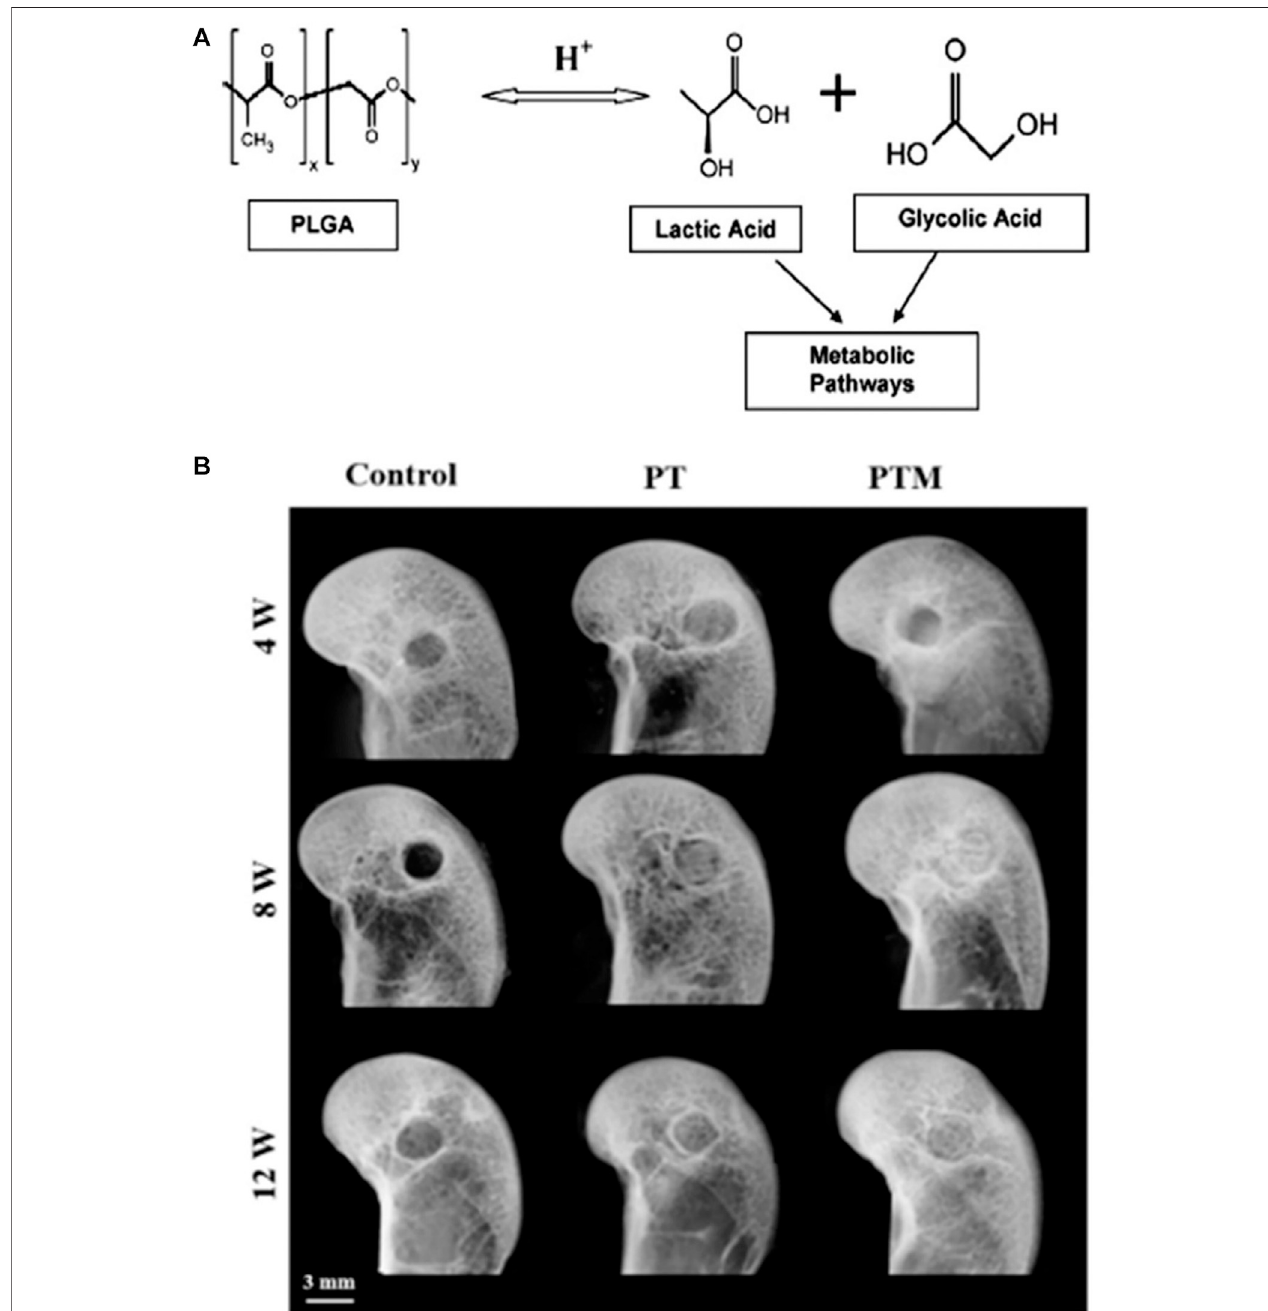
FIGURE6| PLGAforosteonecrosistherapy. (A) HydrolysisofPLGA(Danhieretal.,2012). (B) Representativeradiographsshowedthatnewboneformationwithin bone tunnel at 4, 8, and 12 weeks after surgery (Lai et al., 2019). Reproduced with permission (Danhier et al., 2012). Copyright 2012, Elsevier Ltd. Reproduced with permission (Lai et al., 2019). Copyright 2019, Elsevier